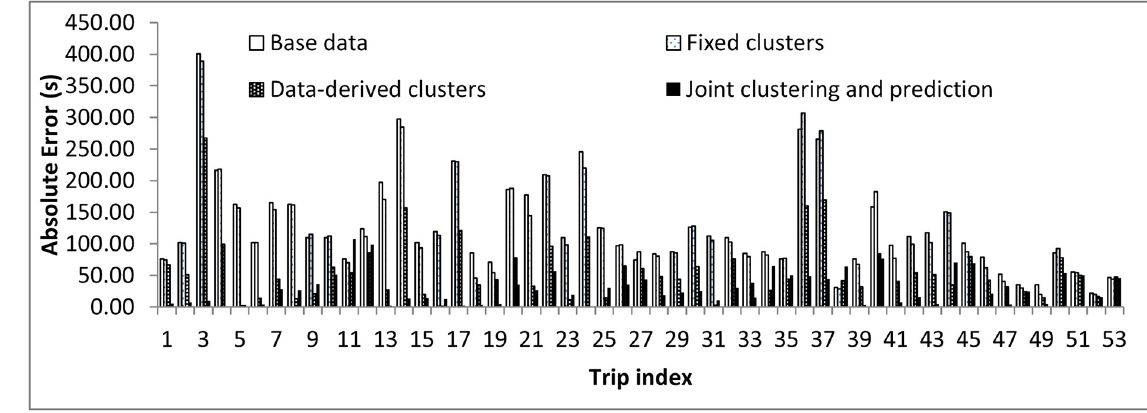
Fig 13. Absolute error for a sample section over time of the